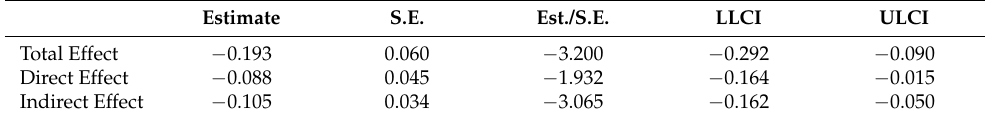
Table 5. Percentile-based bootstrap random sampling results of 5000 times ( N = 354).